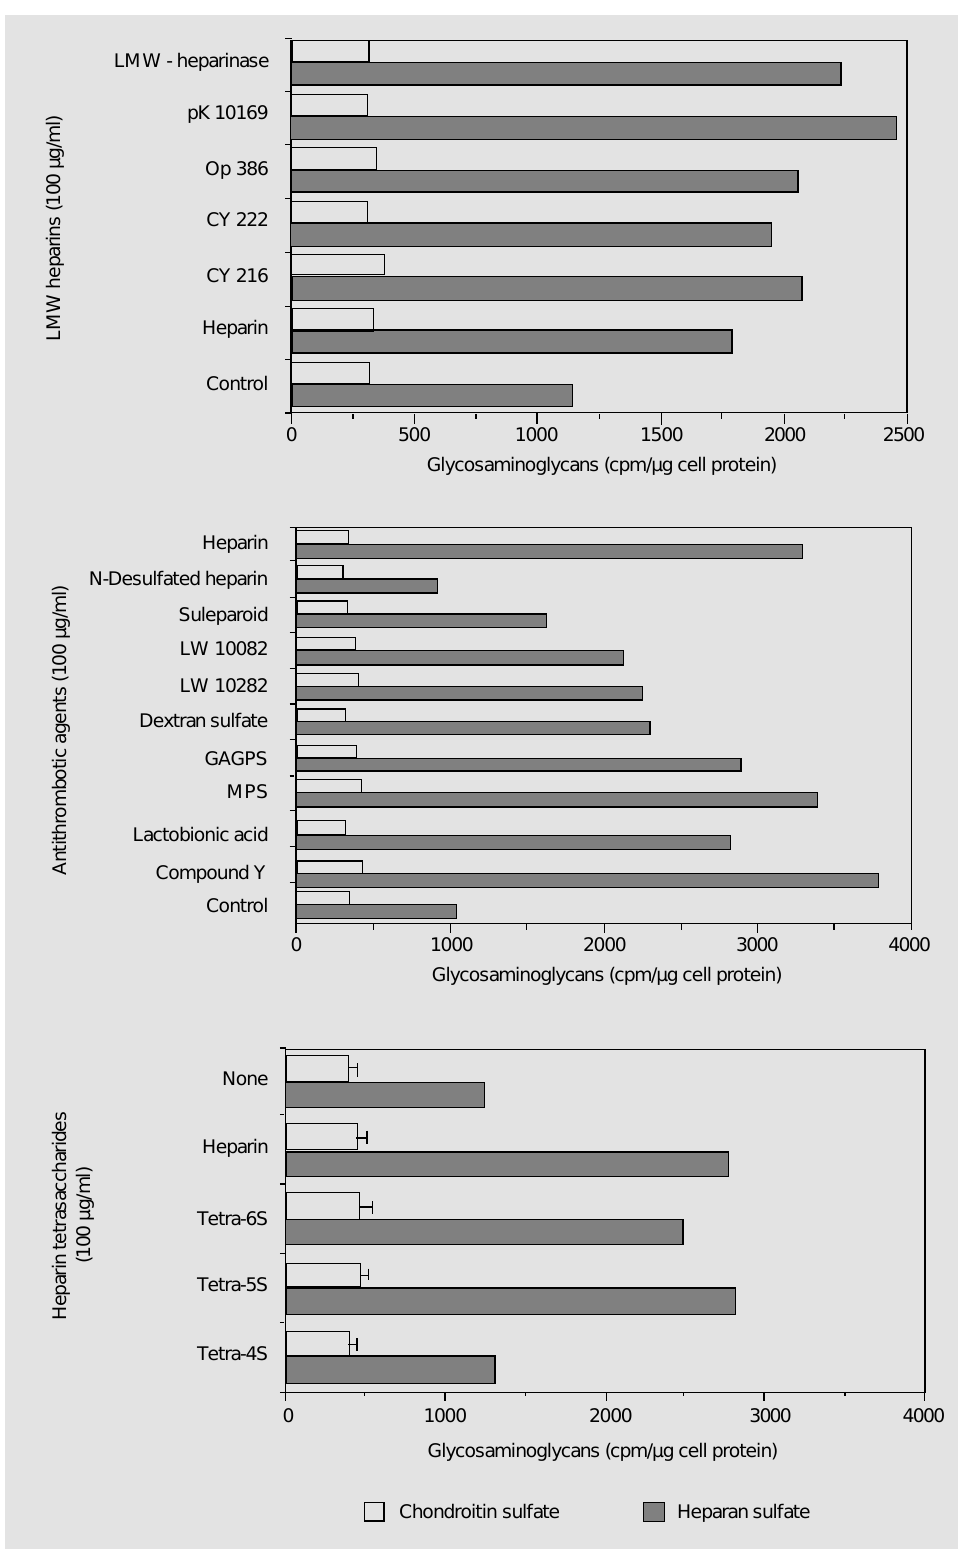
Figure 9. Stimulation of heparan sulfate synthesis in endothelial cells by different antithrombotic agents. GAGPS and MPS: mix- ture of glycosaminoglycans from Organon; Op 386, CY 222, CY 216, LW 10082, and LW 10282: low molecular weight (LMW) heparins from different pharmaceutical industries; sule- paroid: oversulfated chondroitin sulfate; compound Y: cyclic octaphenol-octasulfonic acid; tetra-4S, -5S, and -6S: tetra-, penta- and hexasulfated tetra- saccharides obtained from hep- arin by heparinase